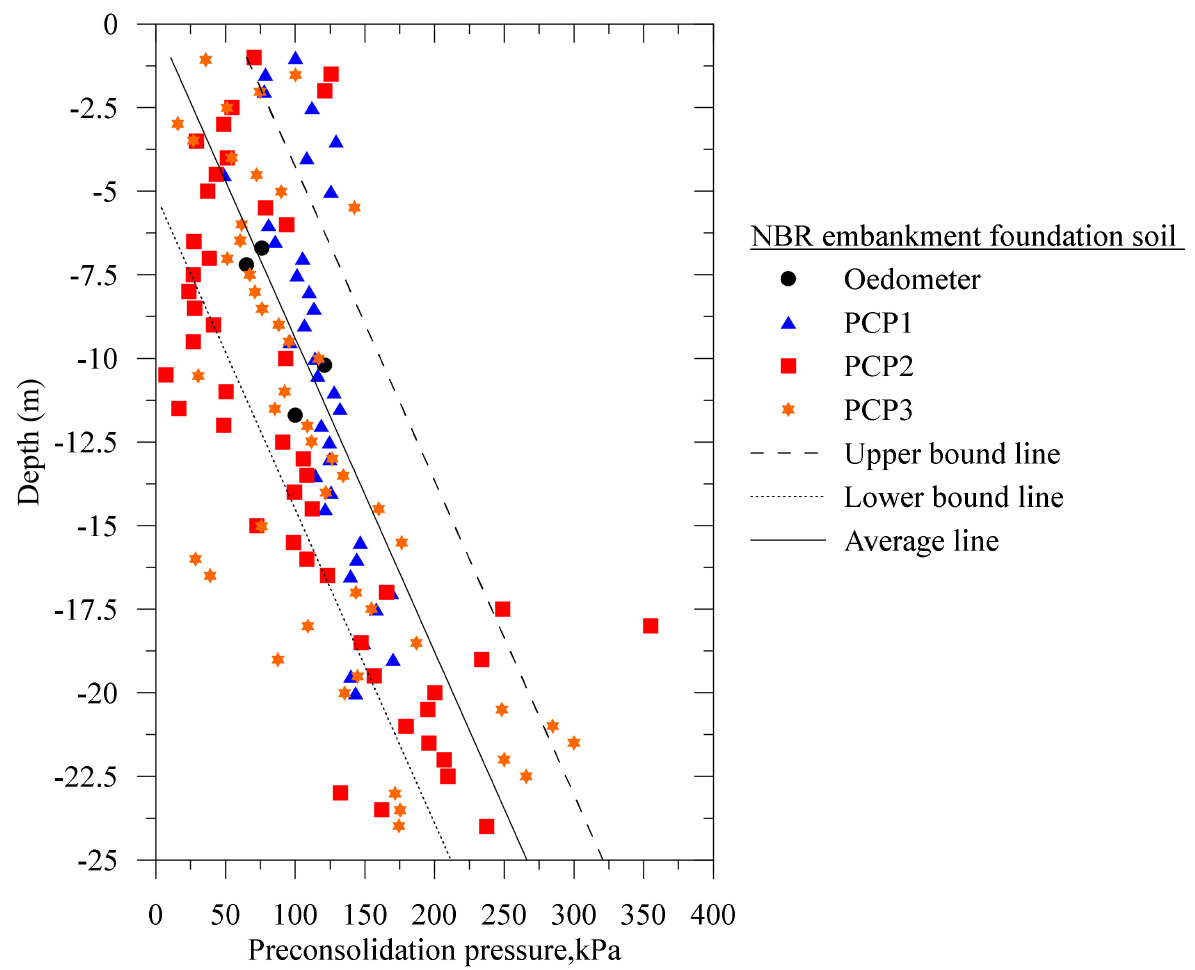
Figure 9. Preconsolidation pressure of the Nerang Broadbeach Roadway embankment’s foundation